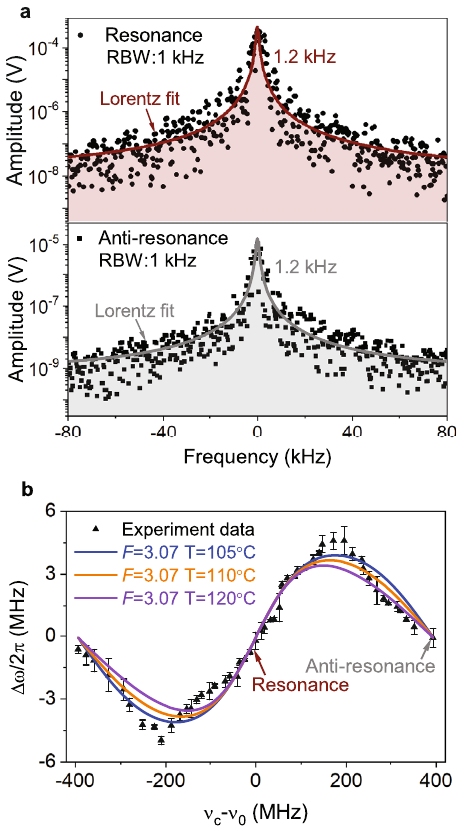
Fig. 3 Linewidth and cavity-pulling characteristics. a Beat-note spectra between the reference laser and the tested laser. Their resolution bandwidths were both 1 kHz with a sweep time of 362 ms. The beating spectrum (black circles) between the reference laser and the resonant tested laser was fi tted by a Lorentzian function with a fi tted linewidth of 1.2 kHz (red line). The Lorentz fi tting linewidth of the beat-note spectrum (black squares) between the reference laser and the inhibited laser was also 1.2 kHz (grey line). The data represented by circles and squares is obtained by optical heterodyne method through single measurement. detuning from the atomic transition frequency ω c − ω 0 , whose adjustable range was one FSR. We modify Eq. (5) with the laser rate equation to describe Δ . The simulated results of Δ at different temperatures for F ¼ 3 : 07 are shown as the solid lines, and the black triangles represent the experimental results. Error bars denote standard deviations from three measurements. The analysis about difference between the simulated data and experimental results is given in the last paragraph of Results Section.